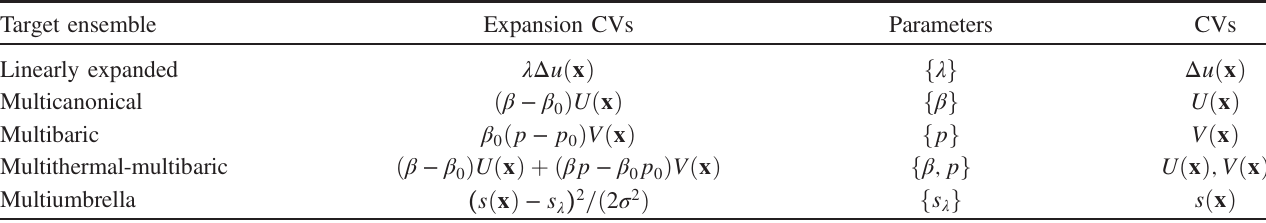
TABLE I. Some of the most common expanded ensembles, together with the expansion collective variables Δ u λ ð x Þ that define the OPES target bias, Eq. (8), and the free-energy differences Δ F ð λ Þ , Eq. (5). Each of the considered target biases can in turn be expressed as a function of one or two CVs. It is also possible to easily combine these ensembles to form new ones, as shown in Sec. VI